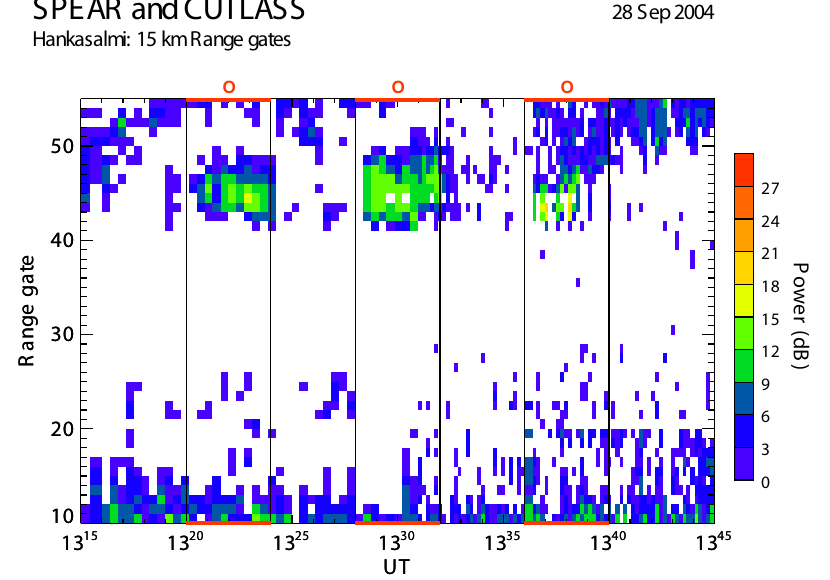
Fig. 14. CUTLASS Finland radar range time amplitude plot showing the first observation of SPEAR induced scatter, 13:15–13:45 UT, 28 September